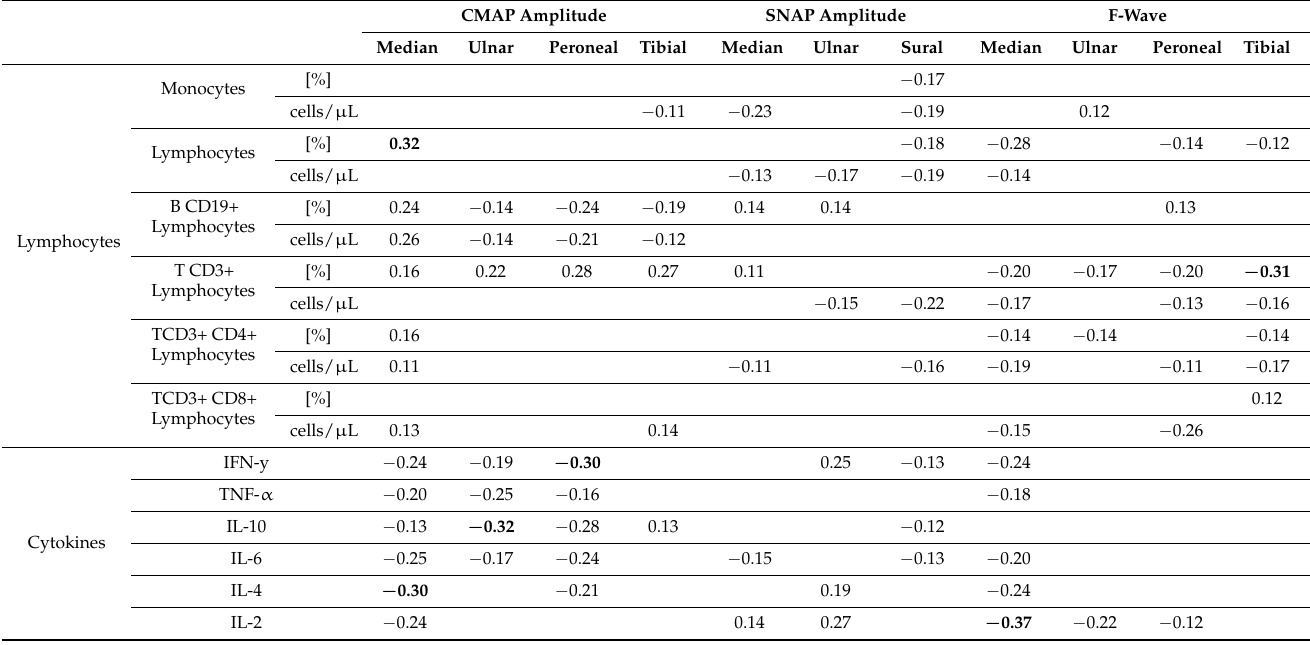
Table 4. Correlations (r > 0.10) between individual lymphocytes, cytokines and electrophysiological parameters (CMAP and SNAP). CMAP Amplitude SNAP Amplitude